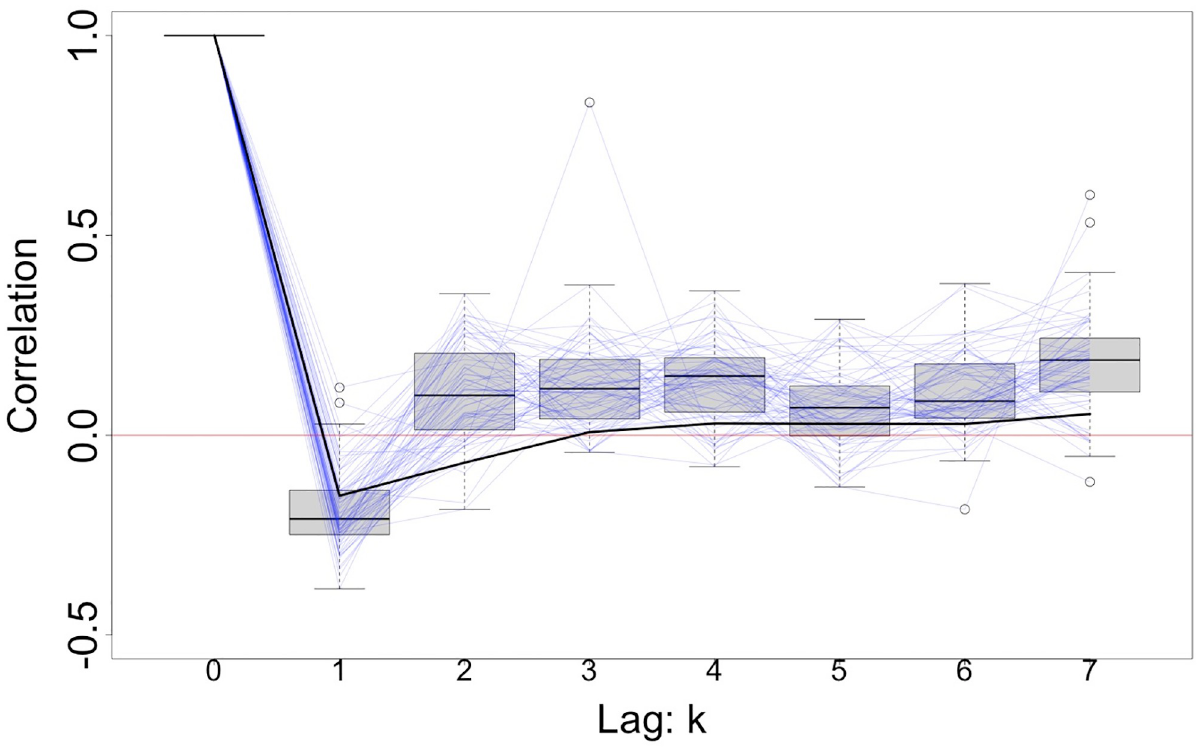
Fig 1. Box plot of the residual autocorrelations, Corr( r obtained from a Poisson generalized linear model with study covariates and a lagged autoregressive predictor ( y i , t − 1 ) as outlined in the COVID-19 data analysis section. Light blue lines connect the autocorrelation values of each county. Solid black line connects the autocorrelation values Corr( r t , r t − k ) calculated with residuals from all counties combined.